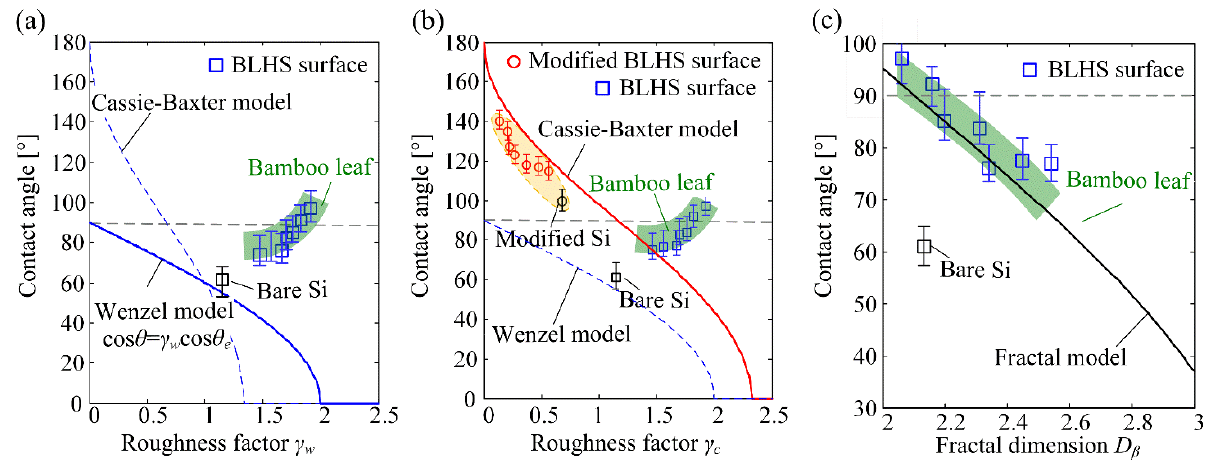
Figure 13. Comparison of the measured contact angles and theoretical values calculated from vari- ous wetting models. ( a ) Wenzel wetting model, ( b ) Cassie wetting model, ( c ) fractal wetting model.